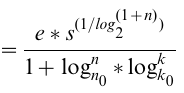
Table 1. MRR of GroupRank in four cancer types.